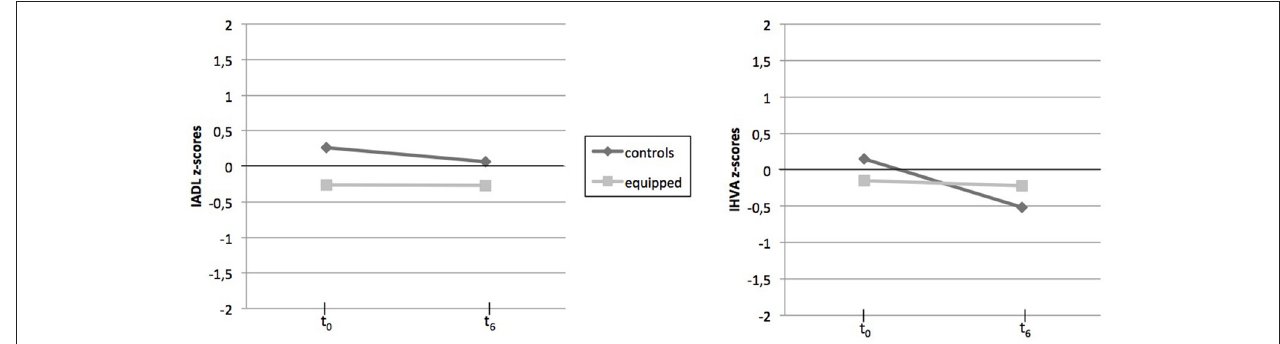
FIGURE 3 | Pre- and Post-intervention z-sores of functional status measures for each group. M, mean; SD, standard deviation, IADL, Instrumental Activities of Daily Living; IHVA, Inventaire des Habilités pour la Vie en Appartement.